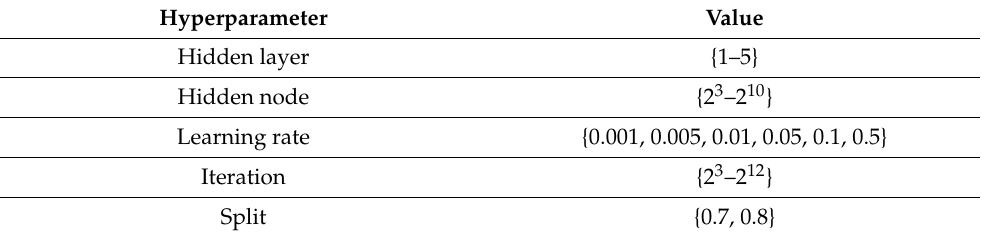
Table 5. Range of Hyperparameters of the Predictive Model.